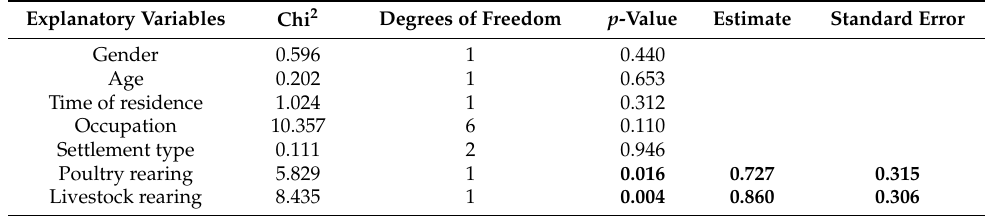
Table 4. Deviance analysis results showing the effect of each factor used in the binomial generalized linear model for the response variable wildlife conflict and their significance, performed with the Anova function of “car” package. Explanatory variables with p -values < 0.05 are in bold. Estimated coefficients and standard errors are shown for the significant categories (yes) of the significant social factors.